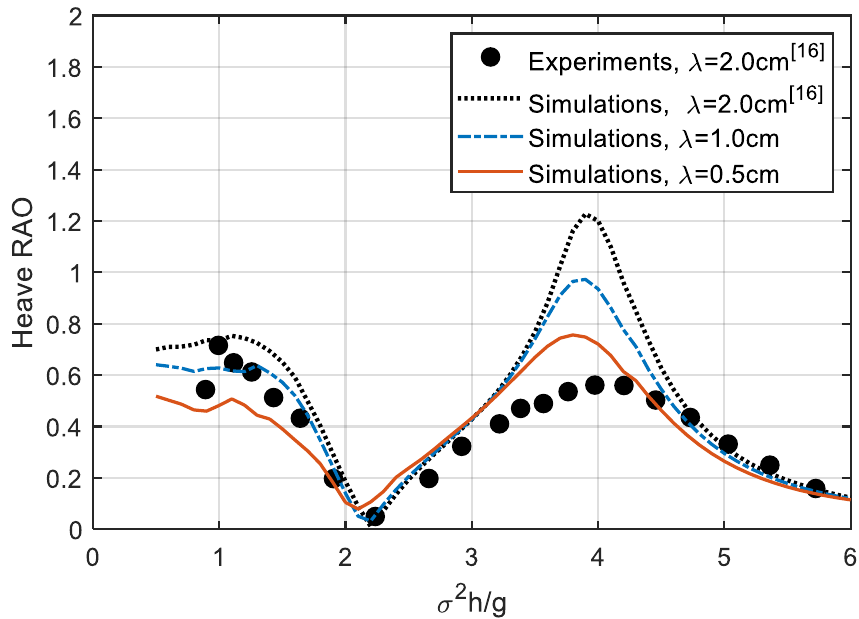
Figure 3. Comparison of the heave RAO for the platform with various fishnet mesh sizes.